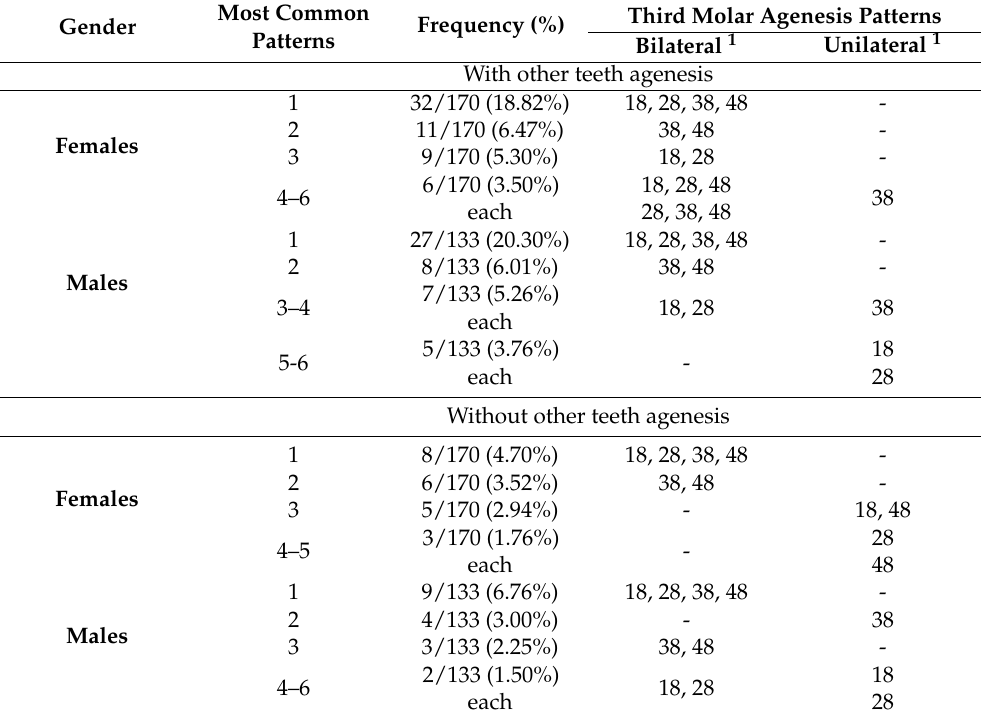
Table 2. The most common third molar agenesis patterns in individuals with and without agenesis of teeth other than the third molars.